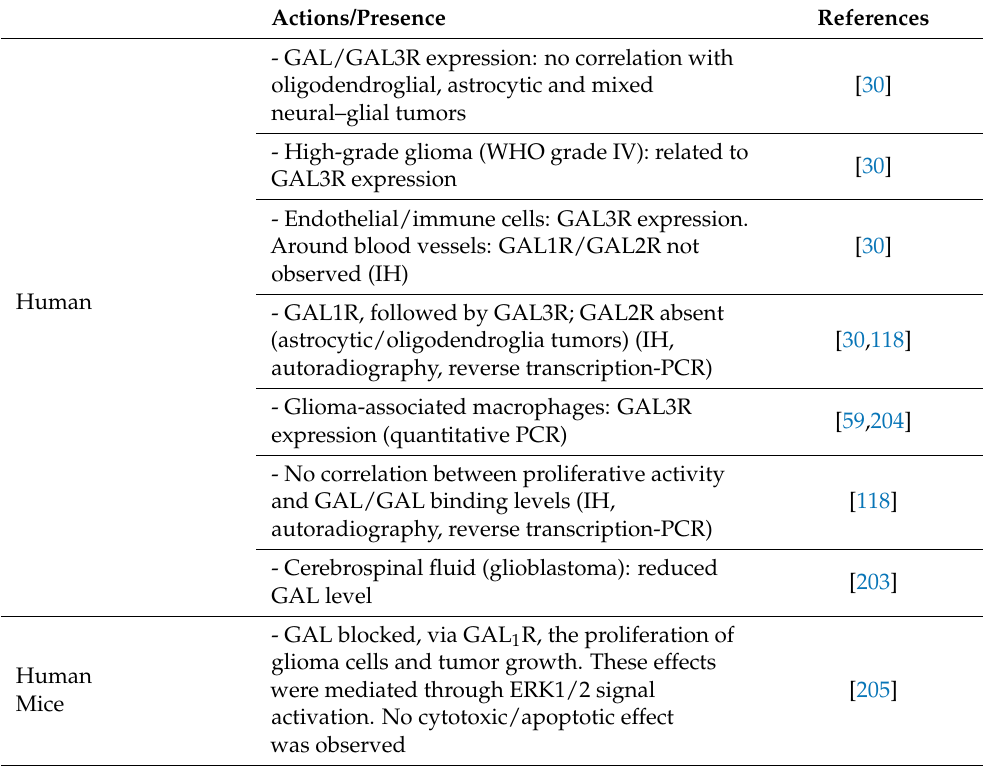
Table 4. Involvement of the galaninergic system in